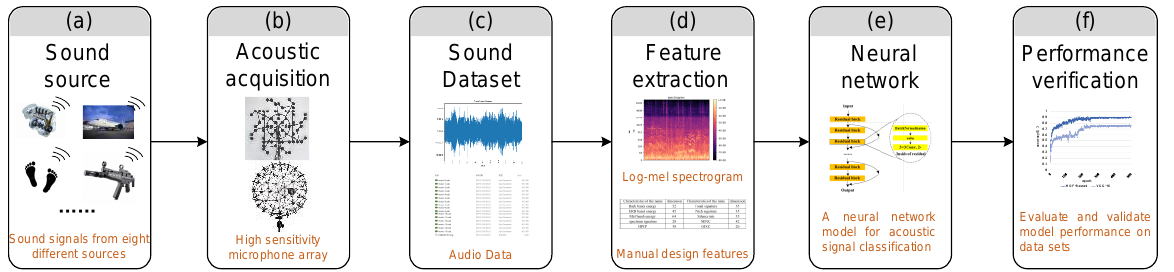
Figure 3. Diagrammatic of acoustic signal classification: Panels ( a – c ) are for sound signal acquisition and storage. Sound signals from different sound sources are collected through the microphone array and stored as audio data. ( c ) The LSE (low-sample environmental) dataset is collected by hardware equipment of sound signal acquisition. The original signals in LSE dataset are waveforms represented in the time domain. The sound signal achieved by the signal hardware acquisition device is converted into an electrical signal and processed. Thus, the sound source signals are changed with time. As shown in panel ( d ), after feature extraction, a log-Mel spectrogram and a series of manual design features are obtained. In panel ( e ), a neural network is used to classify acoustic signals. Finally, we tested the model for its performance, as showed in panel ( f ).